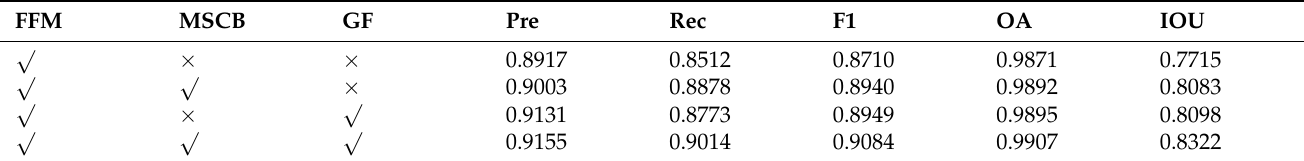
Table 4. The quantitative results of the ablation study on the LEVIR-CD